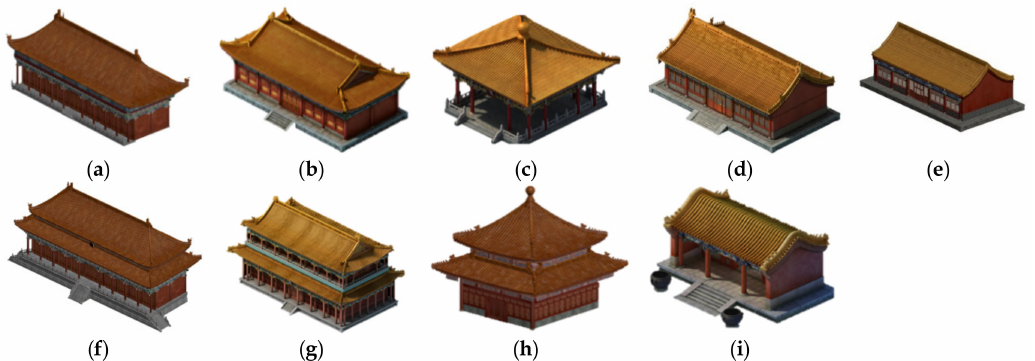
Figure 3. The roof types: ( a ) hip roof; ( b ) gable-and-hip roof; ( c ) pyramidal roof; ( d ) overhanging gable roof; ( e ) flush gable roof; ( f ) double-eave hip roof; ( g ) double-eave gable-and-hip roof; ( h ) double-eave pyramidal roof; ( i ) round ridge